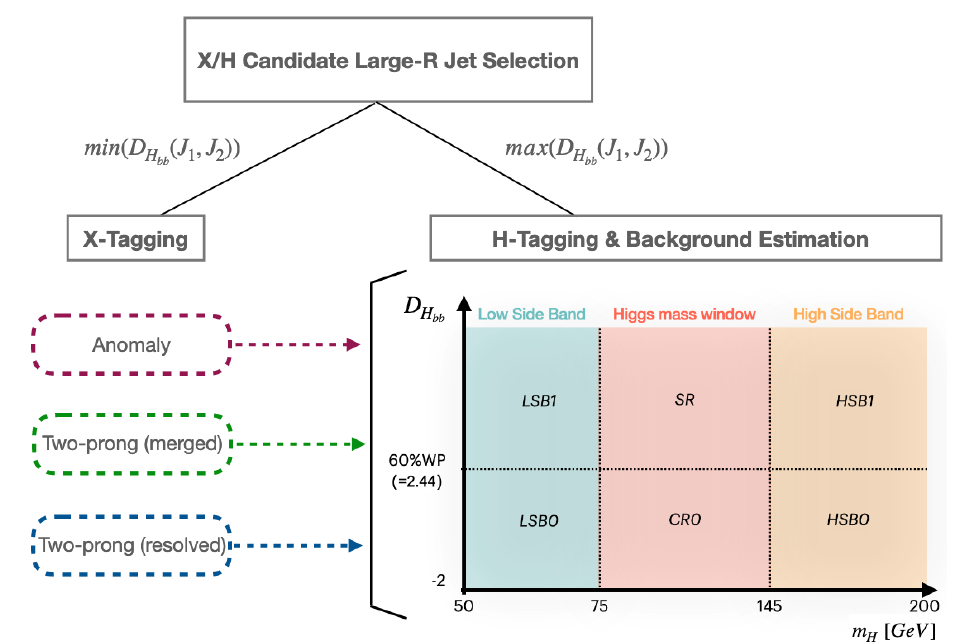
Figure 2. Selection flow after and analysis regions of the Y → XH search. The CRs (CR0, HSB0, HSB1), VRs (LSB0, LSB1), and SR are defined in the same way for all three analyses using the H candidate mass and D X score bb